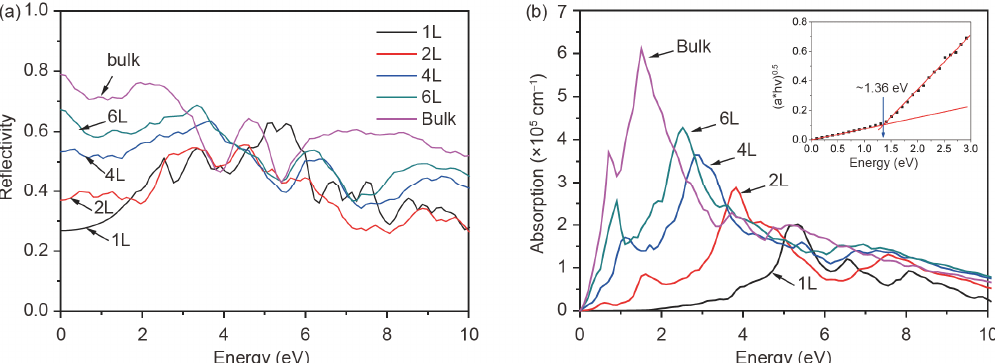
Figure 1. Reflectance of a layer of antimonene and antimonite material: ( a ) reflectance spectra; ( b ) absorption spectra (upper right illustration is the energy band value of single–layer antimonene estimated by the “Tauc” method). Reprinted with permission from Ref. [18]. Copyright 2021, Science China Press.